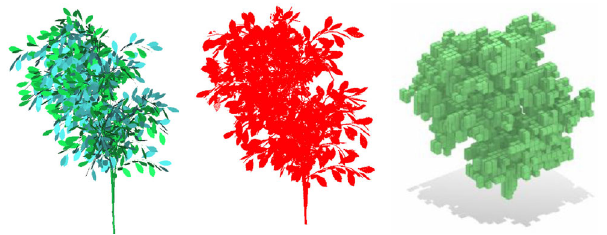
Fig. 4 Data representations. Left to right: triangle mesh, point cloud, voxel.